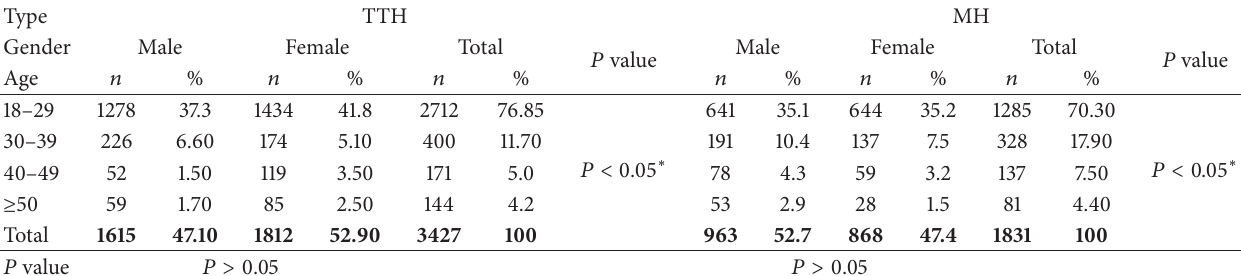
Table 3: Prevalence of migraine and tension-type headache according to ages and gender ( 𝑛 = 5258 ).